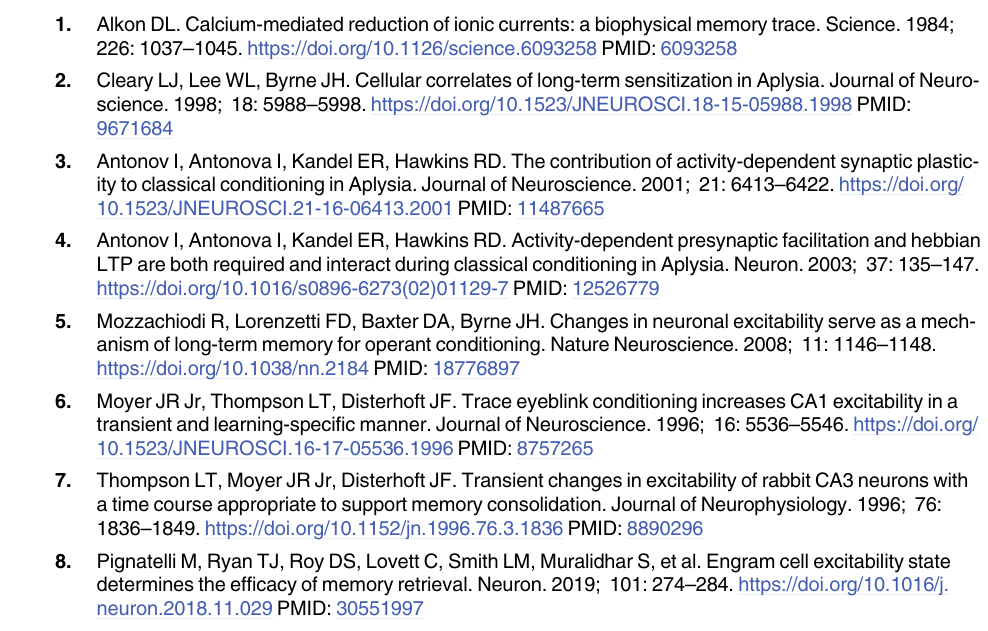
S4 Table. Compensatory eye movement performance and adaptation analysis. S5 Table. Statistical analysis of EBC. EBC, eyeblink